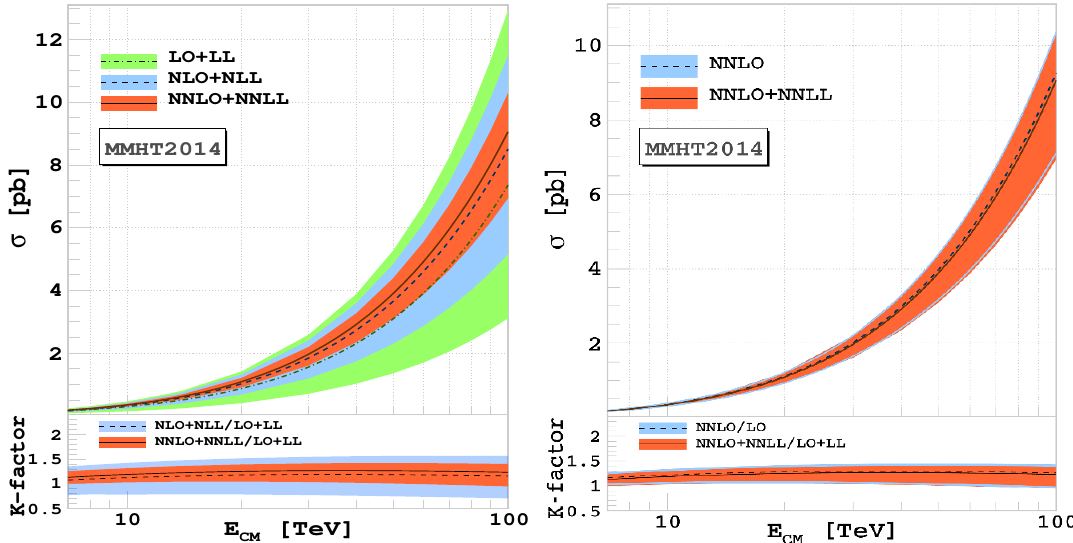
Figure 1 . Left: resummed cross-section plotted against the hadronic center-of-mass energy ( E CM ). The band corresponds to the scale variation around the central scale choice ( (cid:22) ( c ) r ; (cid:22) ( c ) along with the prediction for the central scale. In the lower inset the resummed K-factor has been shown along with scale uncertainties (see text). Right: same plot as the left but for the comparison of (cid:12)xed order and resummed contribution at NNLO